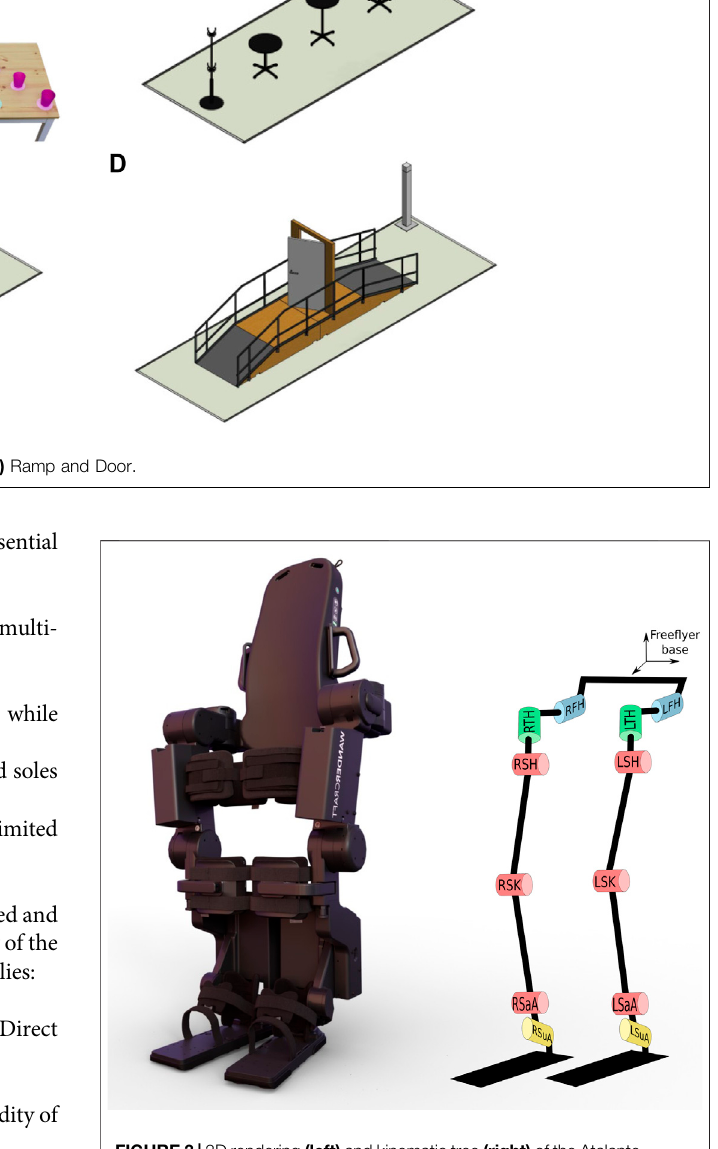
FIGURE 3 | 3D rendering (left) and kinematic tree (right) of the Atalante